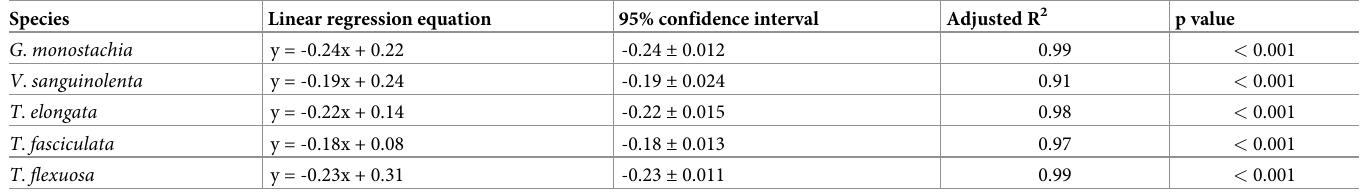
R 2 and p values are also given.